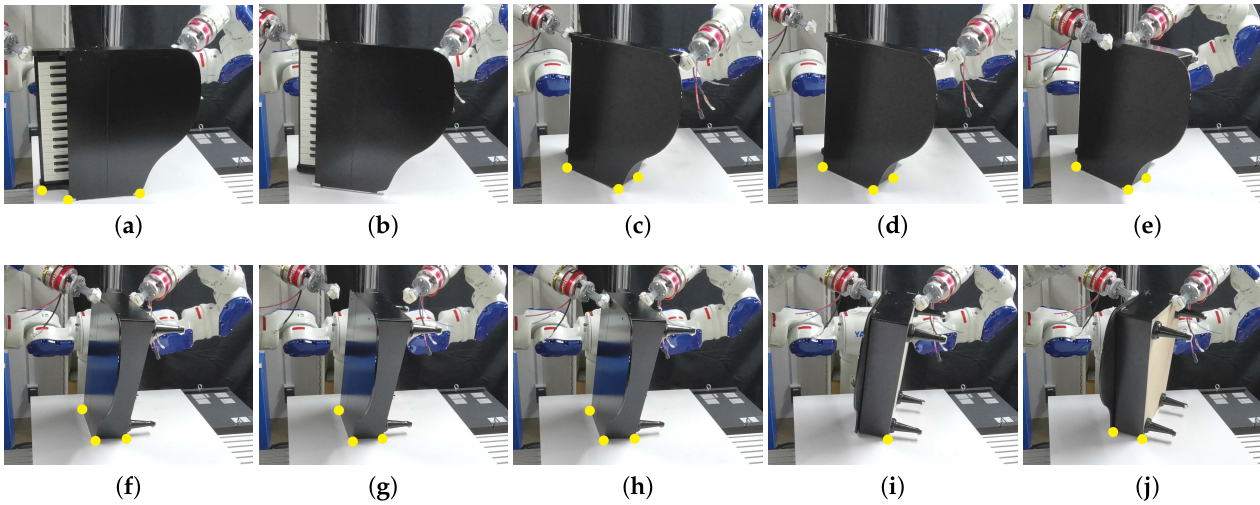
Figure 17. Experiment 2: the robot changes the orientation of the object by pivoting and regrasping. The robot first rotates the object by pivoting in ( a – c ). Then the robot regrasps the object at its new contact surfaces, see ( c – e ) and pivots the object, see ( e , f ). In ( f – h ), the robot changes the grasp configurations and finally pivots the object to the goal pose, see ( h – j